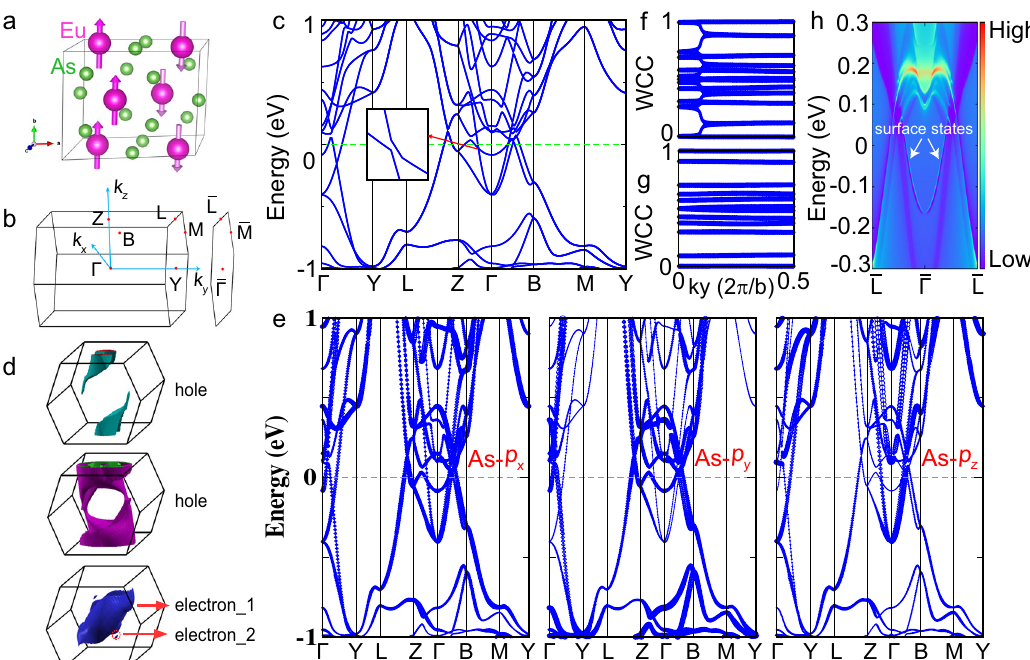
Fig. 1 Topological massive Dirac metal state in the antiferromagnetic state of EuAs 3 , revealed by band calculations. a Schematic for the crystal structure of EuAs 3 in the doubled magnetic unit cell. The arrows on Eu 2 + represent the spin directions, which are parallel and antiparallel to the b axis. b Bulk and (110)-projected surface BZs of the doubled magnetic unit cell of EuAs 3 with several high-symmetry points marked. c Band structure of EuAs 3 from GGA + SOC + U ( U = 5 eV) calculations for the AFM ground state. The inset shows the massive Dirac point with a small gap. d Fermi surfaces of EuAs 3 derived from the band structure. e Projected band structure of EuAs 3 , where the symbol size represents the projected weight of Bloch states onto the As- p x , p y , and p z orbitals as labeled. Band inversion can be observed at the Γ point. The Wannier charge center is calculated in the f k z = 0 and g k z = 0.5 planes. h Calculated surface states on the (010) surface. The nontrivial topological surface states are clearly validate the topological nature, more solid evidences are needed. Other parameters for these four bands, such as the Fermi energy E F , extremal cross-sectional areas A F , Fermi momentum k F , Fermi velocity v F , cyclotron effective mass m ∗ , and Dingle temperature T D , are calculated and summarized in Table 1.